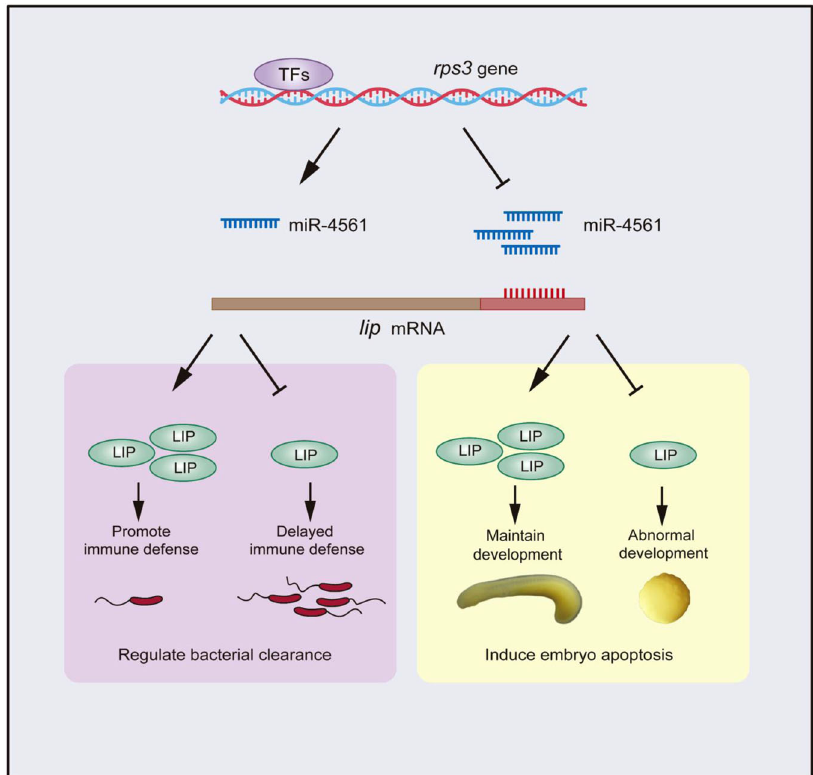
Fig. 9 Regulatory mechanism of miR-4561. Schematic representation of miR-4561-mediated regulation of bacterial clearance and embryo apoptosis through the suppression of the lip